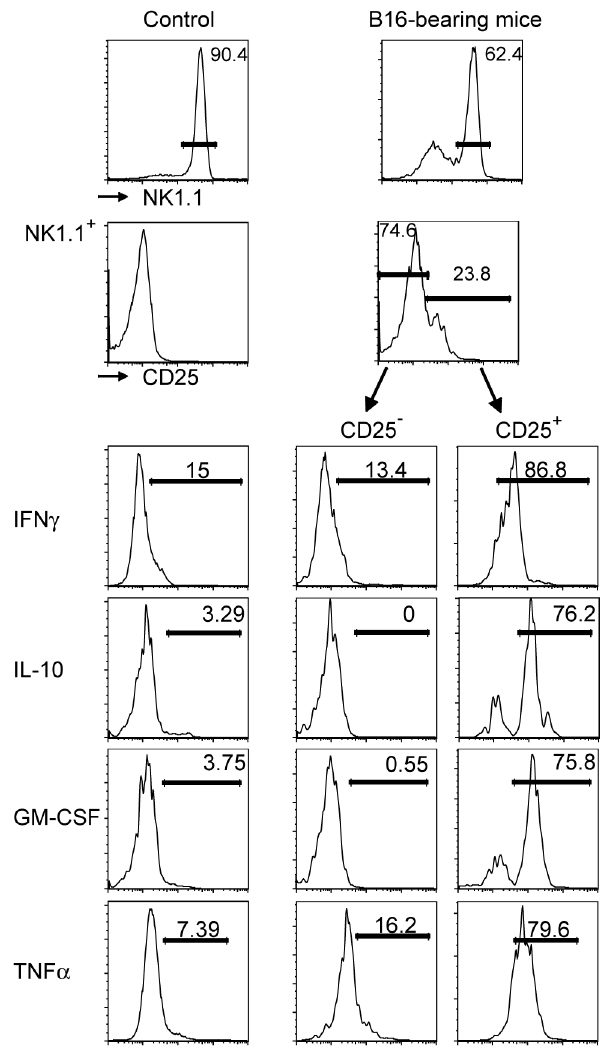
Figure 4. Post-activation NK cells express high levels of cytokines. Spleen cells from control Rag1 -/- mice (left) and from B16- bearing Rag1 -/- mice (right) were incubated for 5 h in brefeldin A and stained for extracellular NK1.1 and CD25 and for intracellular cytokines. Little cytokine expression was observed in control NK cells and in CD25 2 NK cells from B16-bearing mice. In contrast, most CD25 + NK cells from B16-bearing mice had generated IFN c , IL-10, GM-CSF and TNF a . Data were reproducible in three independent